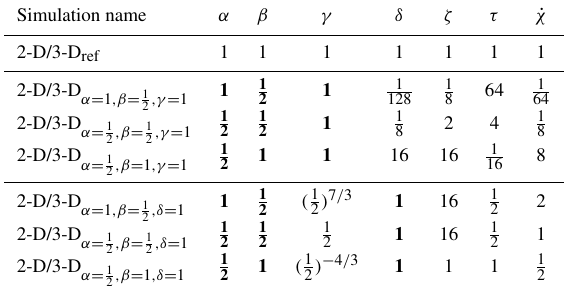
Table 2. Scaling ratios as used for our numerical simulations. Pre- scribed scaling ratios are highlighted in bold and the others result from Eqs. (11)–(17), (22) and (23). Each row corresponds to a scal- ing experiment that is carried out in flow line (2-D) and in a three- dimensional channel setup (3-D). The parameter values prescribed in the simulations are obtained by multiplying b x , b y , C , a and A (see Table 1) with the given ratios α , β , γ , δ and ζ . The analytic val- ues for ˙ χ are used to fit the sections of linear grounding-line retreat in Figs. 5 and